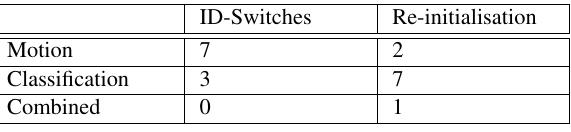
Table 1: Identity switch and re-initialisation